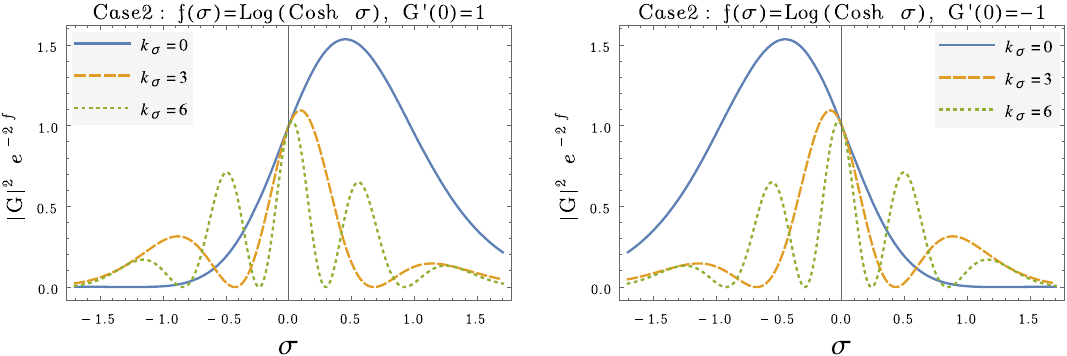
Fig. 2 Left: The overall pre-factor in presence of growing warp factor for G ( 0 ) = 1 and G (cid:4) ( 0 ) = 1. Right: The overall pre-factor in presence of growing warp factor for G ( 0 ) = 1 and G (cid:4) ( 0 ) = −